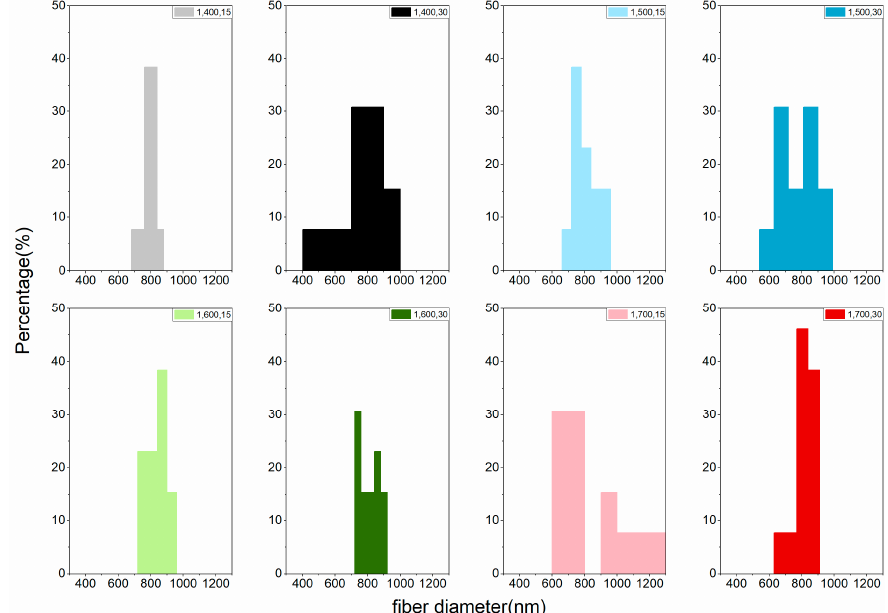
Figure 4. Fiber diameter distribution of the LACFs made with various one-step process, for each